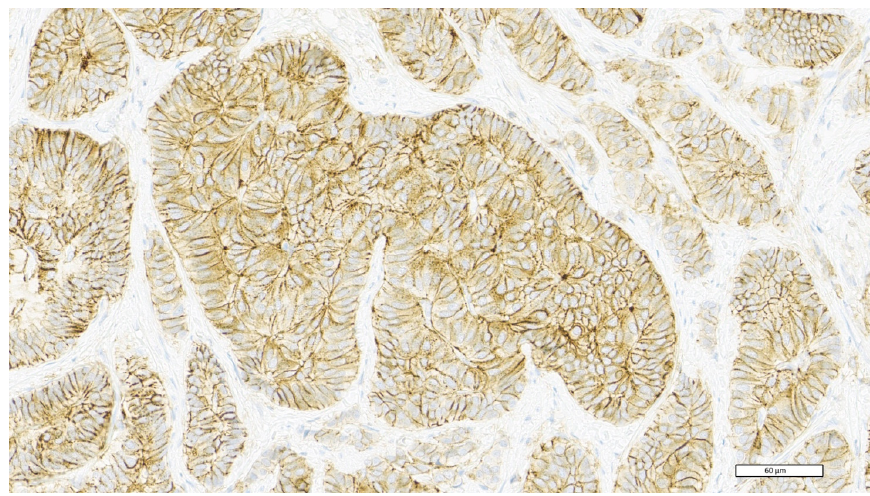
Figure 1. CD44 high expression—score 3+: intense membrane staining in at least 10% of tumor cells.